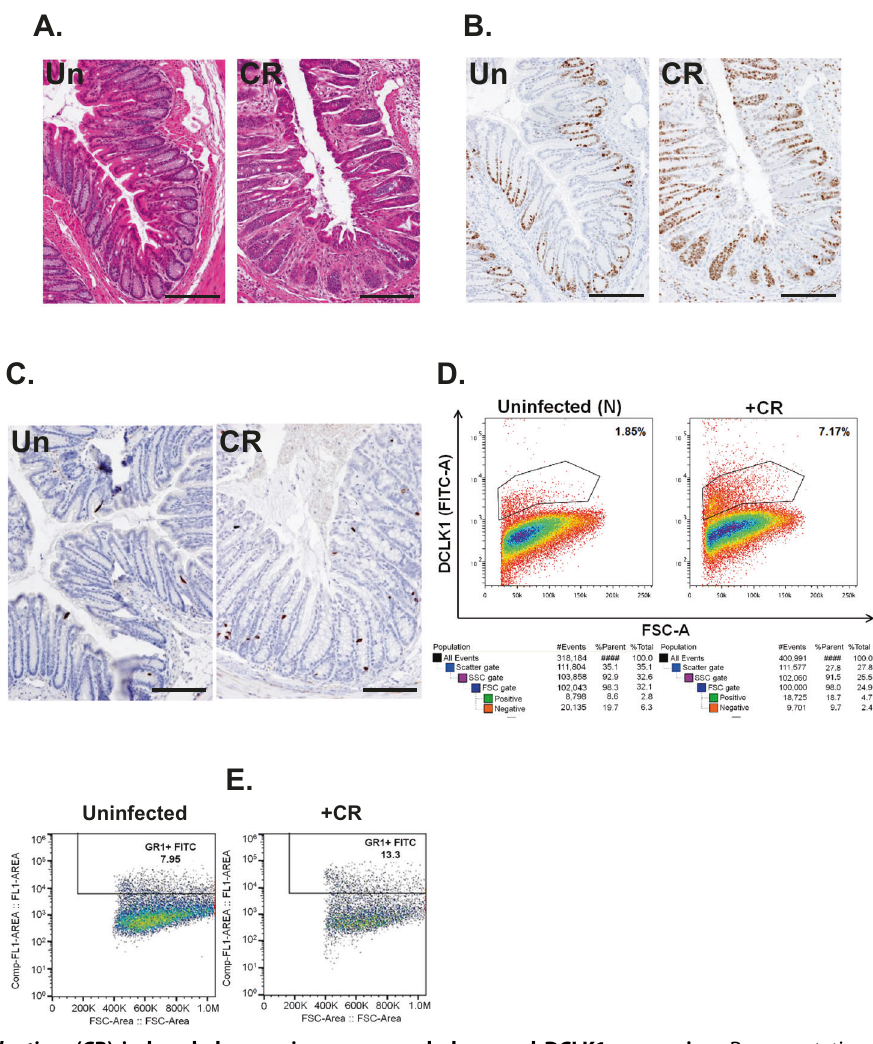
Fig. 3 Citrobacter rodentium (CR) induced changes in gross morphology and DCLK1 expression. Representative H&E ( A ), Ki-67 ( B ), and DCLK1 ( C ) immunostaining of distal colons from uninfected (N) or CR-infected Rag1 − / − mice (scale bar 100 μ m; 7 – 8 mice/group; n = 3 independent experiments). D Representative fl ow cytometry performed in crypt epithelial cells isolated from uninfected or CR-infected Rag1 -/- mouse colons for DCLK1 (lower panel represents the gating strategy). E Representative fl ow cytometry performed in the colons of uninfected or CR-infected wild-type C57BI/6j for